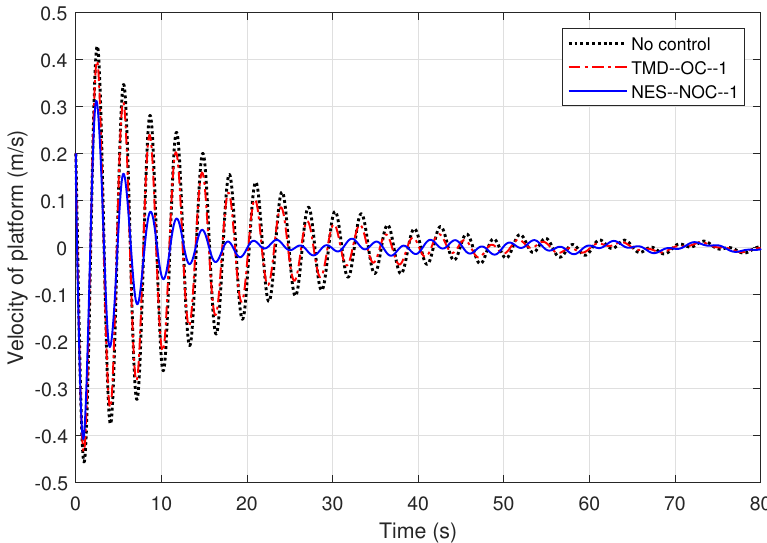
Figure 14. Velocities of the structure without control, with TMD–OC–1 and